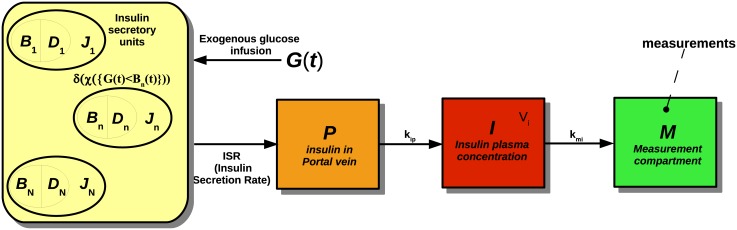
Scheme of the in vitro model.Block diagram of the model for the in vitro experiments. B
1…B
N and D
1…D
N are respectively thresholds and potentiations of the different controllers, while J
1…J
N indicate the amount of releasable insulin for each controller. P represents the portal vein, I is the plasma insulin compartment, M the measurement compartment. The quantity G(t) is the external glucose concentration.